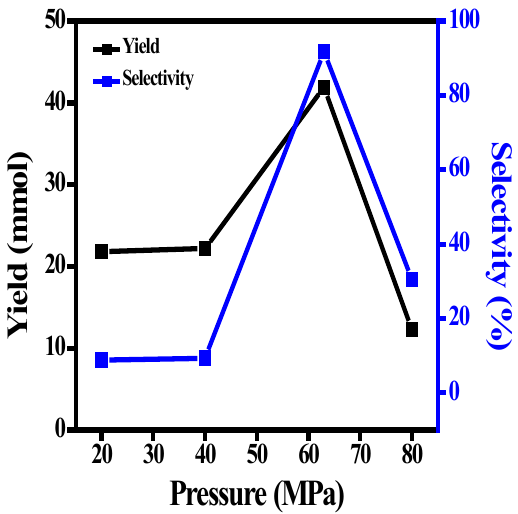
Figure 9: Effect of EG[Vim] of DMC production under reaction conditions: MeOH: 625 mmol, IL:1.28 mmol, DMAP: 4.1 mmol, CO